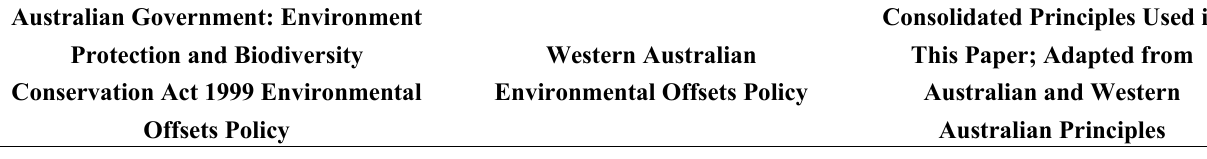
Table 1. Principles for the use of environmental offsets for the Australian and Western Australian Governments [11,12] and consolidated principles adapted for this